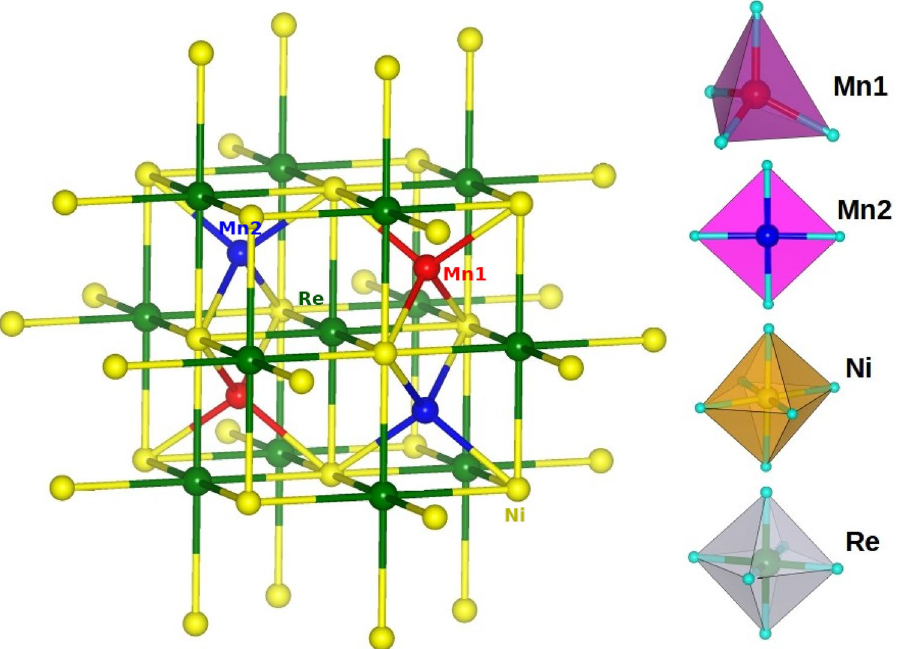
Figure 1. Crystal structure of the stoichiometric CMNRO compound. CMCRO compound is isostructural to CMNRO. The left panel shows the three dimensional network of four magnetic ions in the structure with Mn at tetrahedral site (Mn1), Mn at square planar site (Mn2), Ni and Re atoms marked as red, blue, yellow and green coloured balls respectively. The right panel shows the oxygen coordination of the four magnetic ions, tetrahedral for Mn1, square planar for Mn2, and octahedral for Ni and